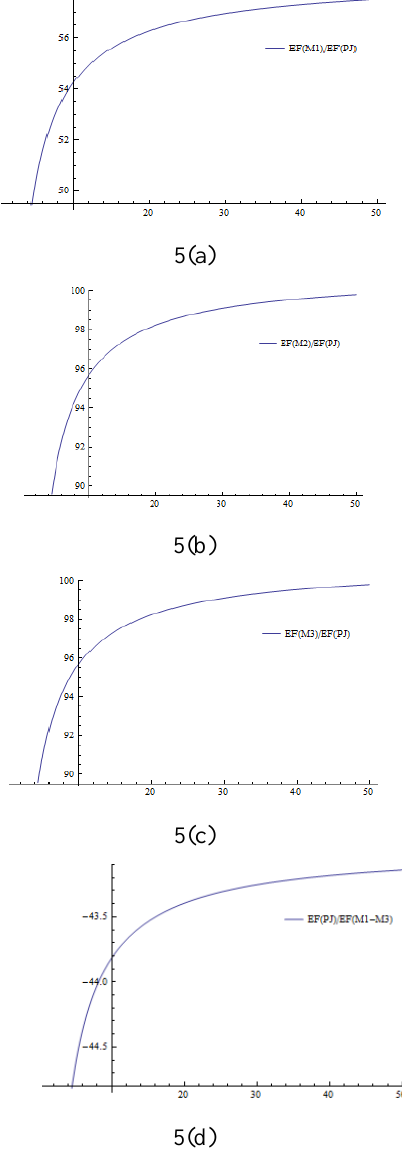
Fig. 5. (a-d), shows computational efficiency of methods method